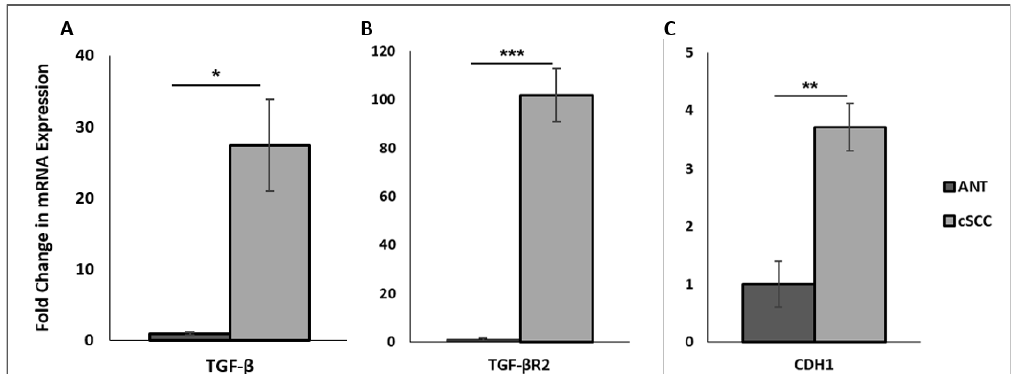
Figure 1. Fold change in TGF- β (Panel A ), TGF- βR2 (Panel B ), and E-cadherin (CDH1; Panel C ) mRNA expression between ANT and cSCC tissues. All values are expressed as mean ± SEM. * denotes p < 0.05, ** denotes p < 0.01, and *** denotes p < 0.001.